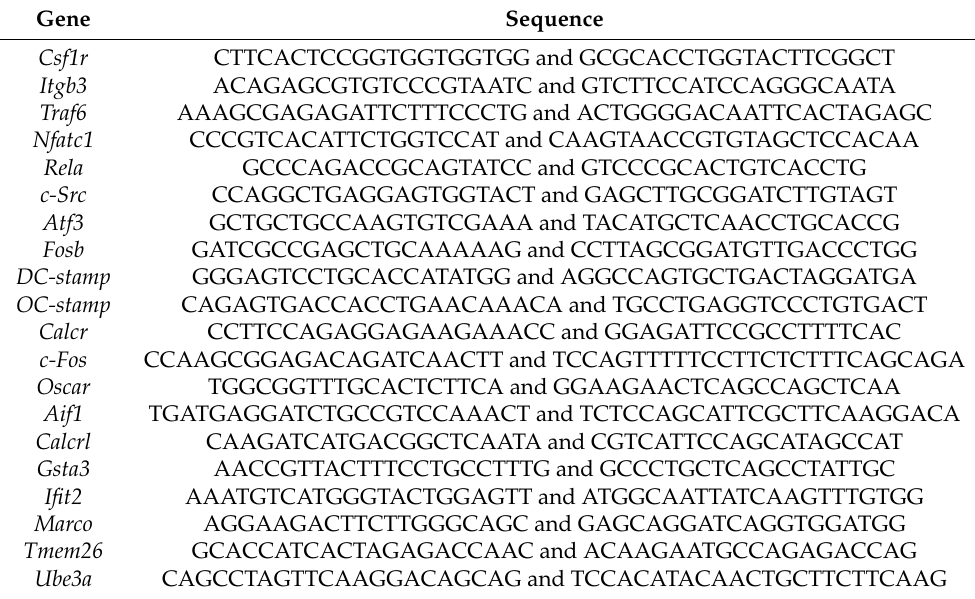
Table 4. Primers for